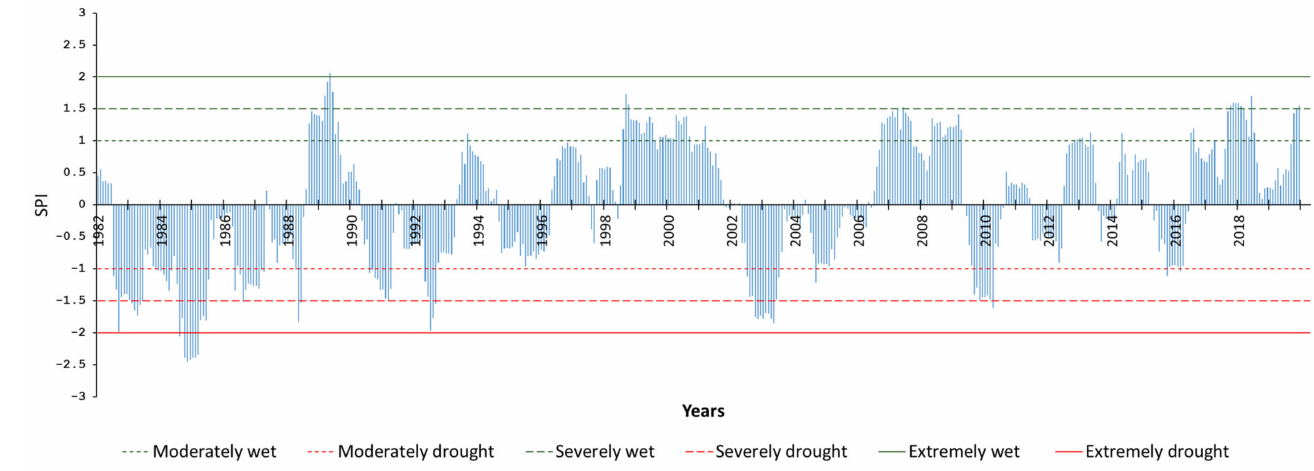
Figure 7. The 12 months SPI for the Blue Nile